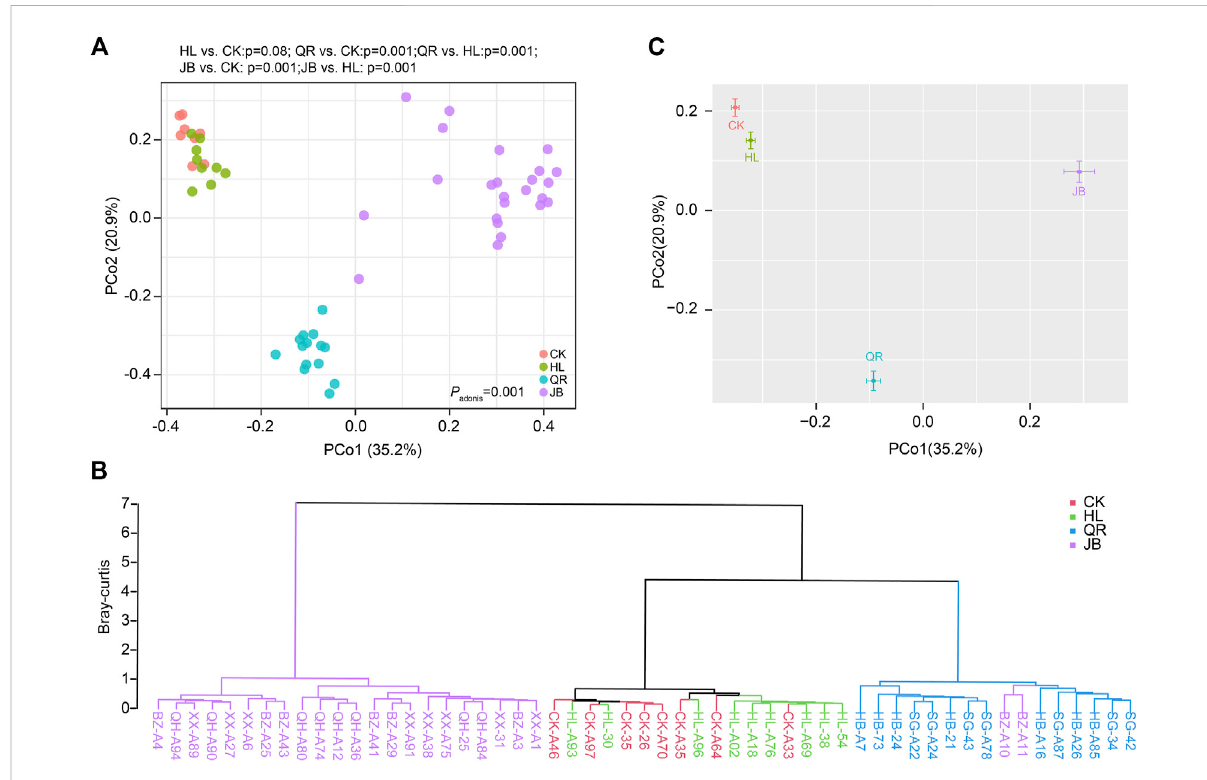
FIGURE 5 The alteration of gut fungal structure after antipyretic and diaphoretic drugs treatment. The structure of gut fungal was assessed by PCoA analysis which was presented by samples (A) or merged groups (C) . (B) Clustering analysis based on bray-curtis